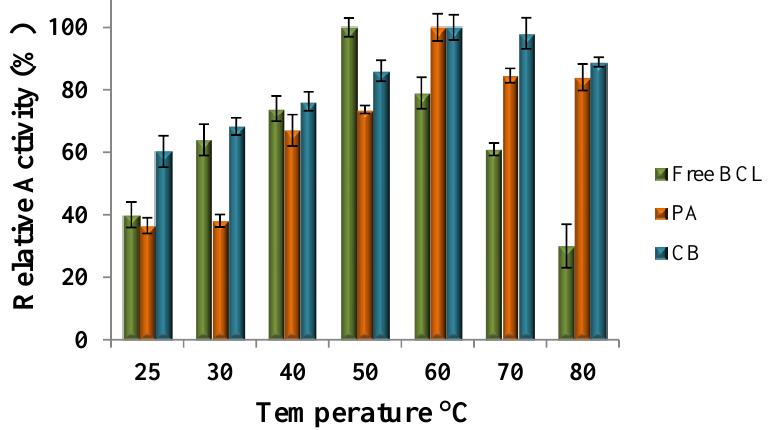
Figure 4. Temperature effect on the activity of the free and immobilized BCL, by physical adsorption (PA), and covalent binding (CB).